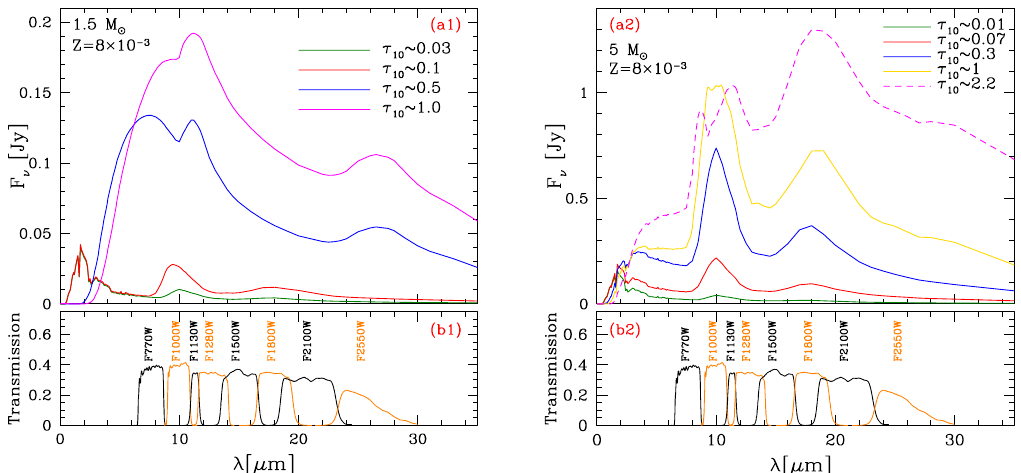
Figure 2. ( a1 , b1 ): Evolution of the spectral energy distribution of a 1.5 M (cid:12) model star, in 4 stages chosen during the AGB phase. Green and red lines refer to the initial oxygen-rich phase, whereas the blue and magenta tracks are chosen within the C-rich evolution. ( a2 , b2 ): Solid lines refer to 4 evolutionary phases, taken during the AGB evolution of a 5 M (cid:12) model. The dashed line shows the SED of the star in case that τ 10 = 2; this value of the optical depth is not expected on the basis of the dust modelling used here, but is demanded by the